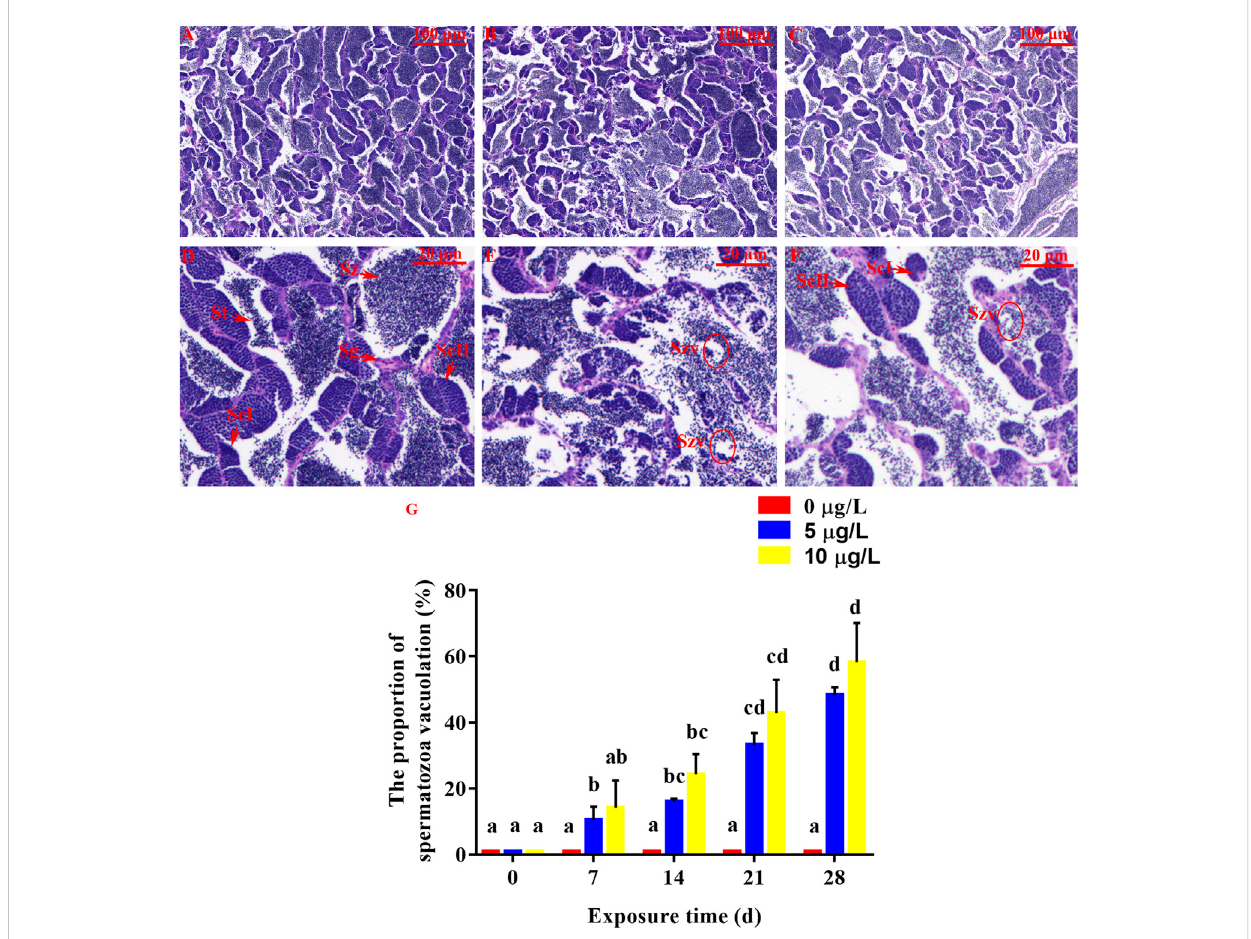
FIGURE 6 Effect of Cd exposure on testistissuein rare minnow. (A, D) Normal testis(exposed to 0 μ g/L Cd). Numerous spermatozoa (Sz) can be observed. (B, C, E, and F) . Testis of Cd exposure groups (exposed to 5 or 10 μ g/L Cd). Increased spermatozoa vacuolate (Szv) can be observed. (A – C) Original picture. (D – F) Partialenlarged detail. (G) Theproportion ofspermatozoa vacuolation inmale rareminnows ( Gobiocypris rarus ).Bar withdifferentletters between the control and exposed groups in the same day indicates statistically signi fi cant differences ( p < 0.05). Spermatozoa = Sz, spermatogonium =